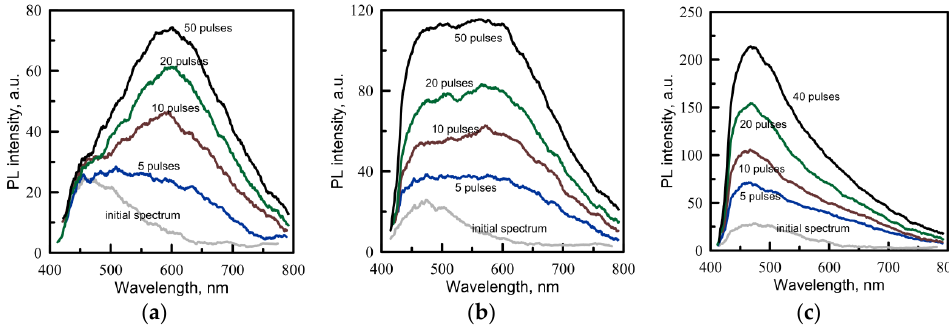
Figure 5. The evolution of photoluminescence (PL) emission spectra of 1% Cd(C 12 H 25 S) 2 /PMMA samples irradiated with various numbers of UV laser pulses. The laser fluence is 150 mJ/cm 2 ( a ), 190 mJ/cm 2 ( b ), and 290 mJ/cm 2 ( c ).